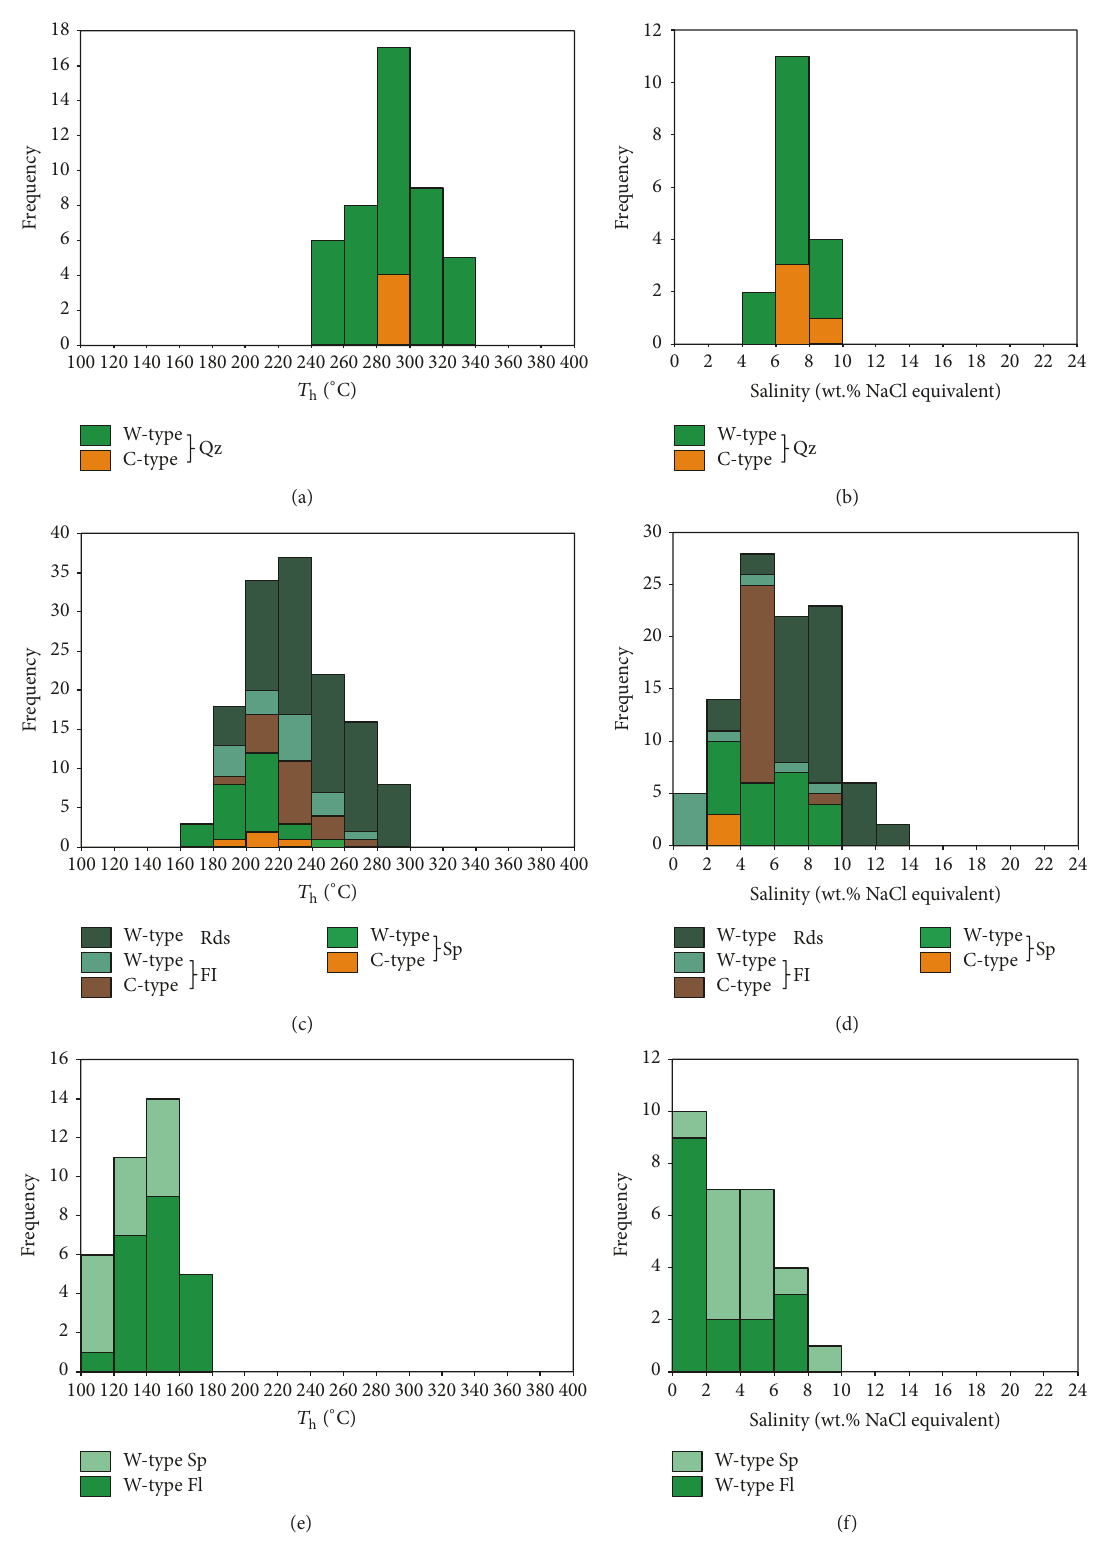
Figure 10: Histograms of homogenization temperatures ( 𝑇 h ) and salinities of C-type and W-type fluid inclusions in the early stage (a, b), the main stage (c, d), and secondary W-type fluid inclusions from fluorite and sphalerite which represent the late stage (e, f). Qz, quartz; Rds, rhodochrosite; Sp, sphalerite; Fl,